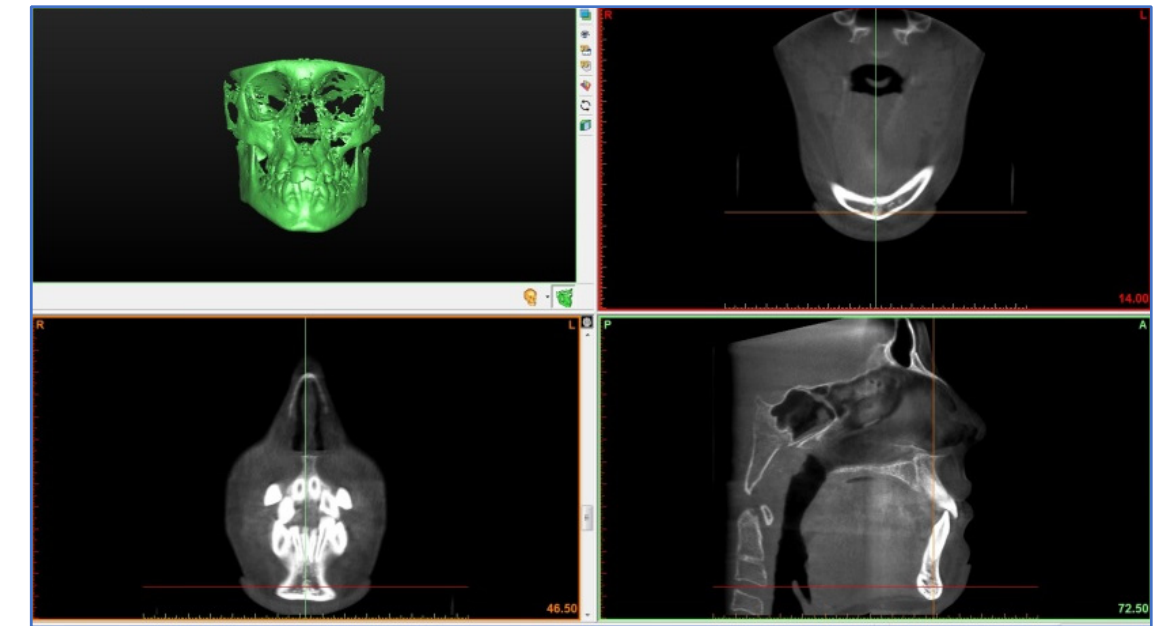
Figure 1. 3D rendering and vertical, transverse and sagittal projections provided by Simplant software.